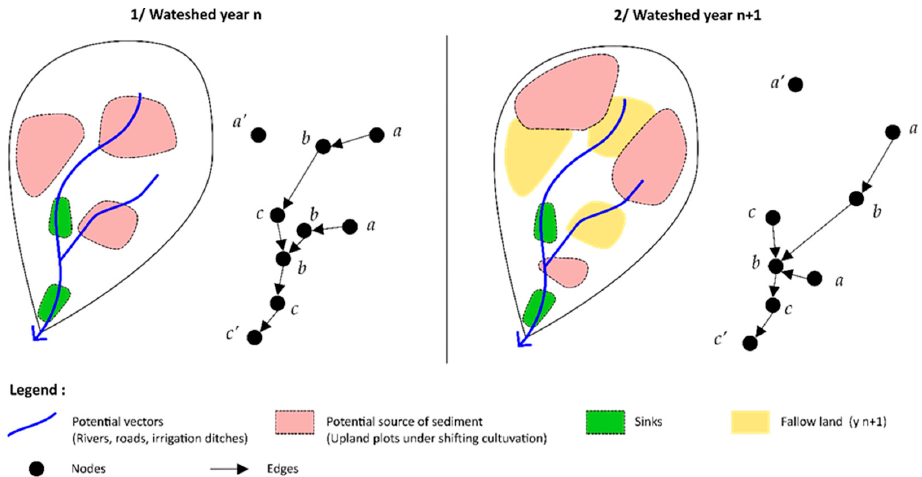
Figure 2. Principle of structural connectivity transposed to graph theory with: (a) potential sediment sources; (a’) disconnected potential sources; (b) connected potential sources; (c) sinks; (c’) outflow (channel network).